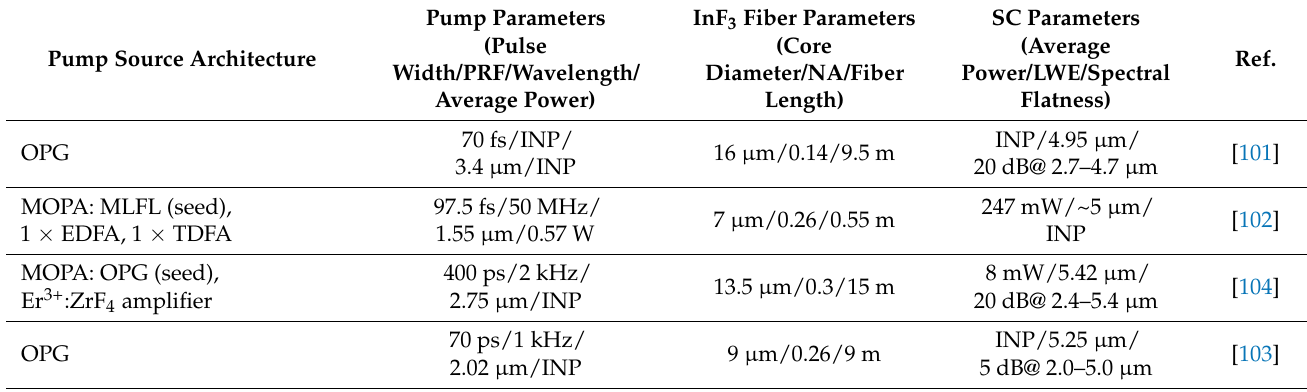
Table 1. Summary of key results of and setups for SC generation in fluoroindate fibers (OPG—optical parametric generator; MOPA—master oscillator power amplifier; DFB—distributed feedback; EDFA— erbium-doped fiber amplifier; EYDFA—erbium:ytterbium-doped fiber amplifier;